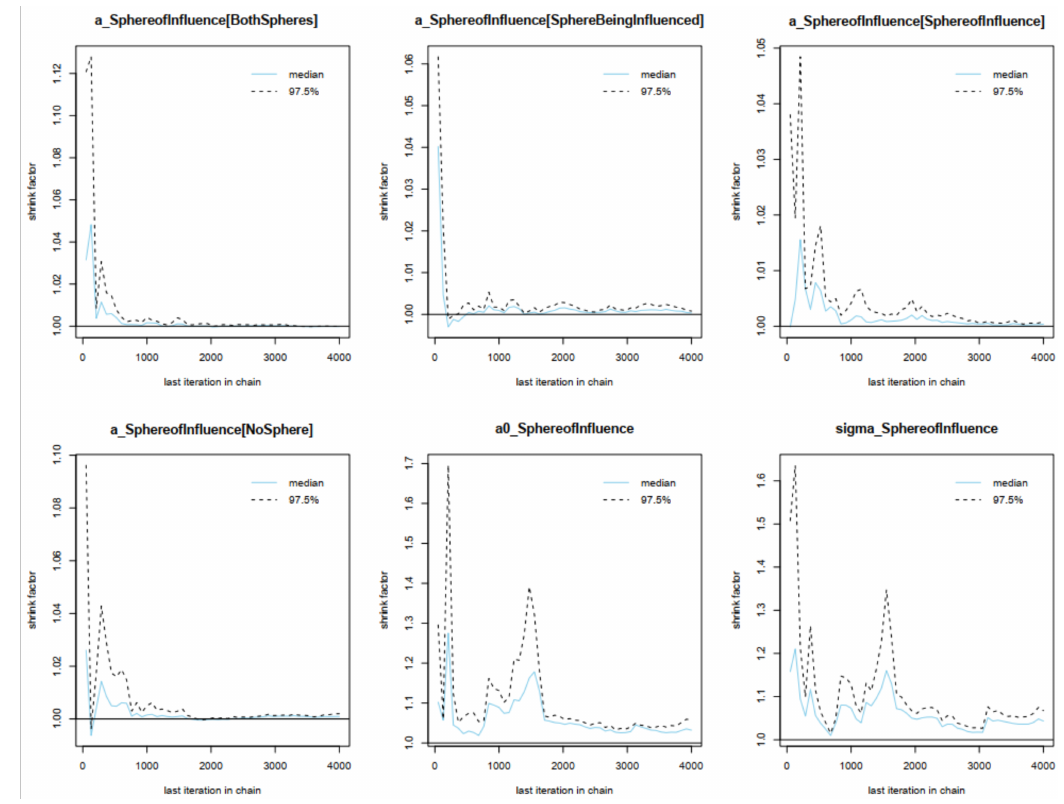
Figure A8. Model 3 (cid:48) s Gelman–Rubin–Brook plots.